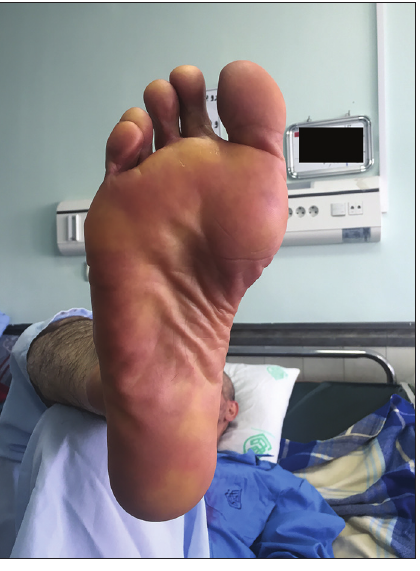
Figure 2. Palmoplantar Erythrodysesthesia Syndrome in feet with less severity following induction regimen for treating acute myeloid leukemia (AML).